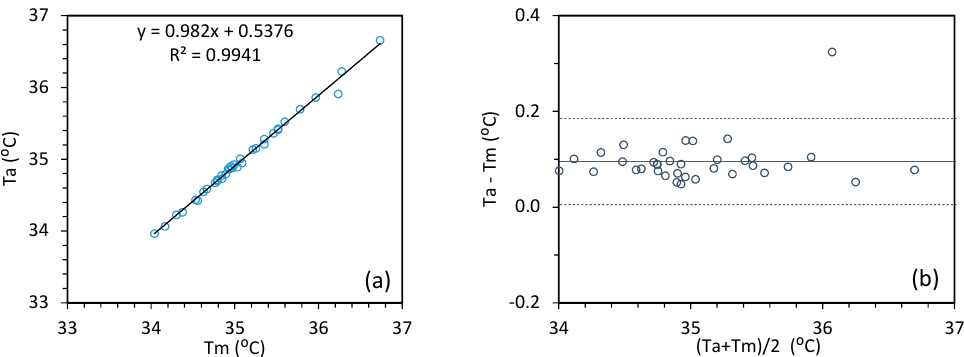
Figure 11. Automatic versus manual canthi temperature measurement ( a ) and the Bland-Altman plot ( b ).